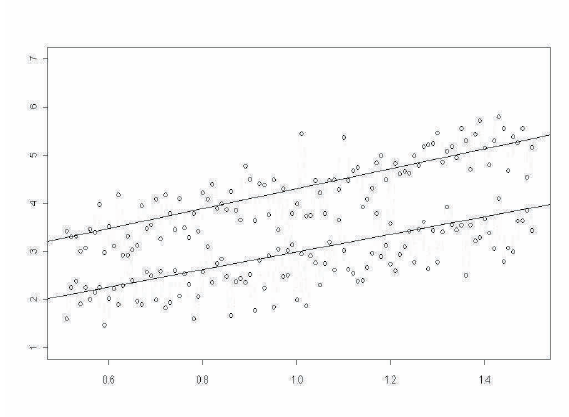
Fig. 1. Simulated data (100 observations) and interval- valued linear regression function: y = [ 1 . 06 , 2 . 02 ] + [ 1 . 66 , 2 . 32 ] x .